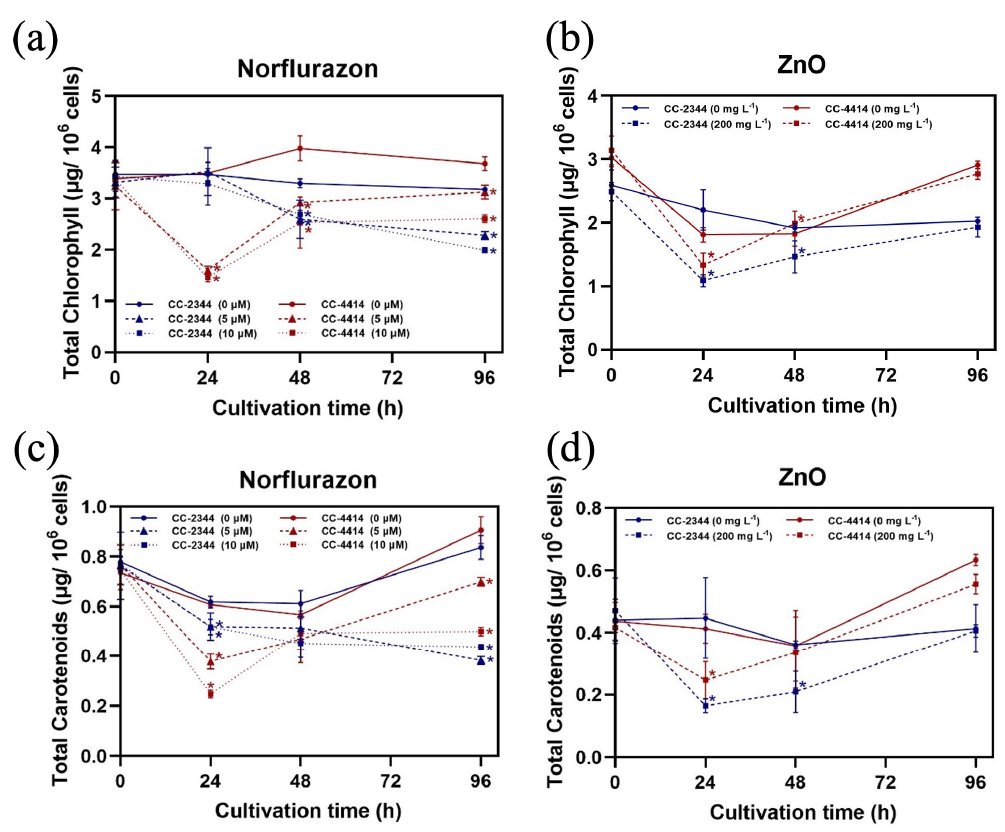
Figure 4. Pigment content per cell unit. Chlorophyll content ( a , b ) and carotenoid content ( c , d ) under norflurazon and ZnO NP conditions, respectively. Blue and red solid lines are CC − 2344 and CC − 4414 with no chemicals, respectively. Blue and red dashed lines and dotted lines represent CC − 2344 and CC − 4414 with the indicated concentration of the chemical, respectively. All data are means ± SD of three biological replicates. Significant differences between the control culture and the chemical-added culture within the same condition are indicated by asterisks (*) ( p < 0.05).